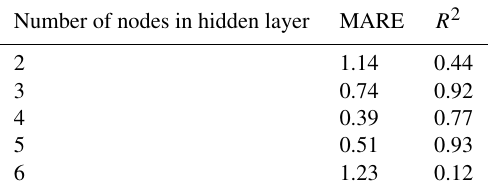
Table 5. MARE and R 2 of the artificial neural network in the veri- fication phase. Number of nodes in hidden